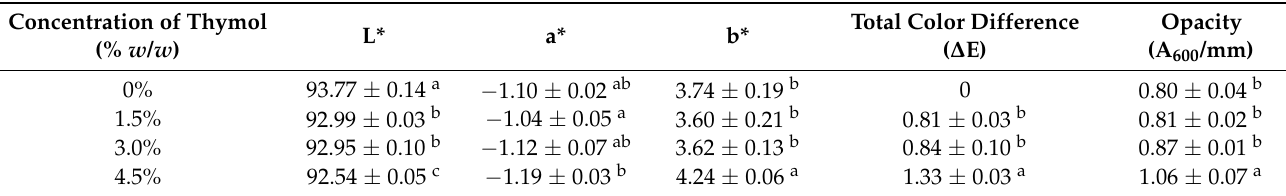
Table 2. Optical properties of starch/CNP/Thy bio-nanocomposite films incorporated with different concentrations of thymol. The data are reported a mean ± SD, n = 3 and p < 0.05. Concentration of